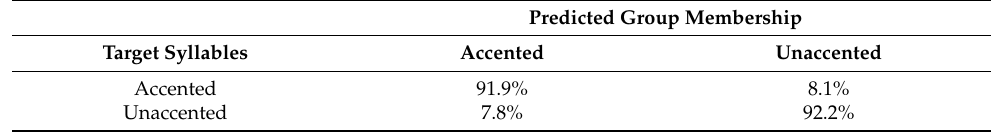
Table 8. Confusion matrix for the classification results of the English speakers with